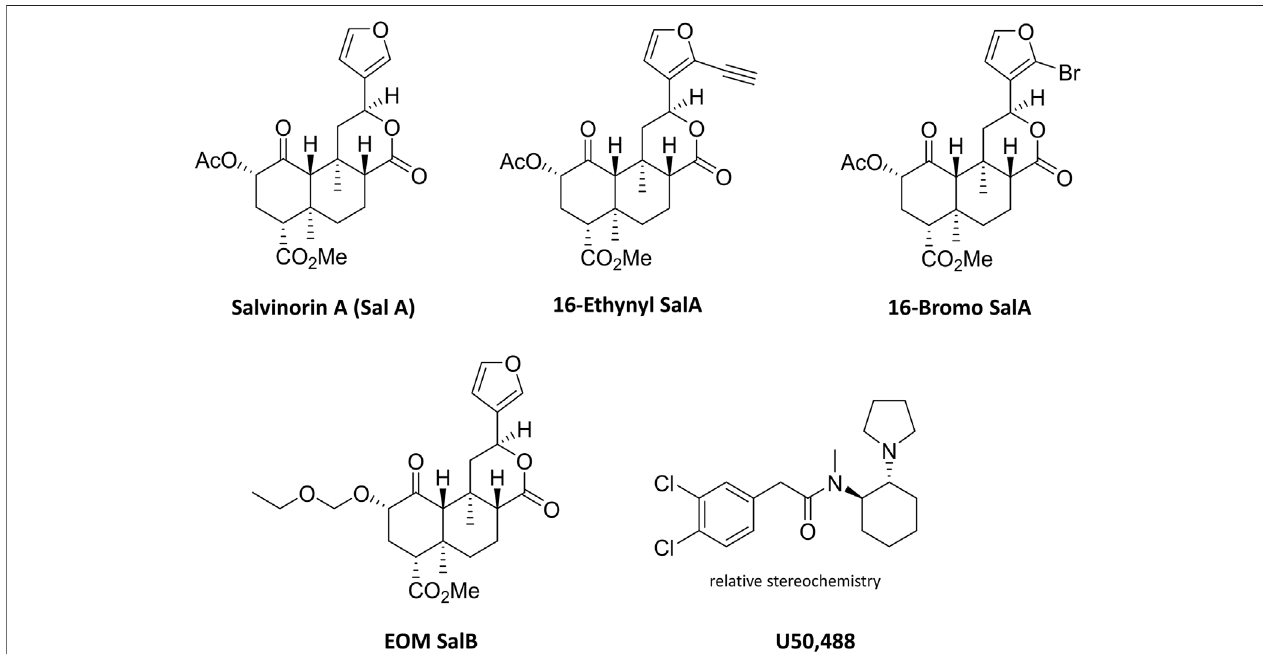
FIGURE 1 | Chemical structures of Salvinorin A, 16-Ethynyl SalA, 16-Bromo SalA, EOM SalB, and U50,488.